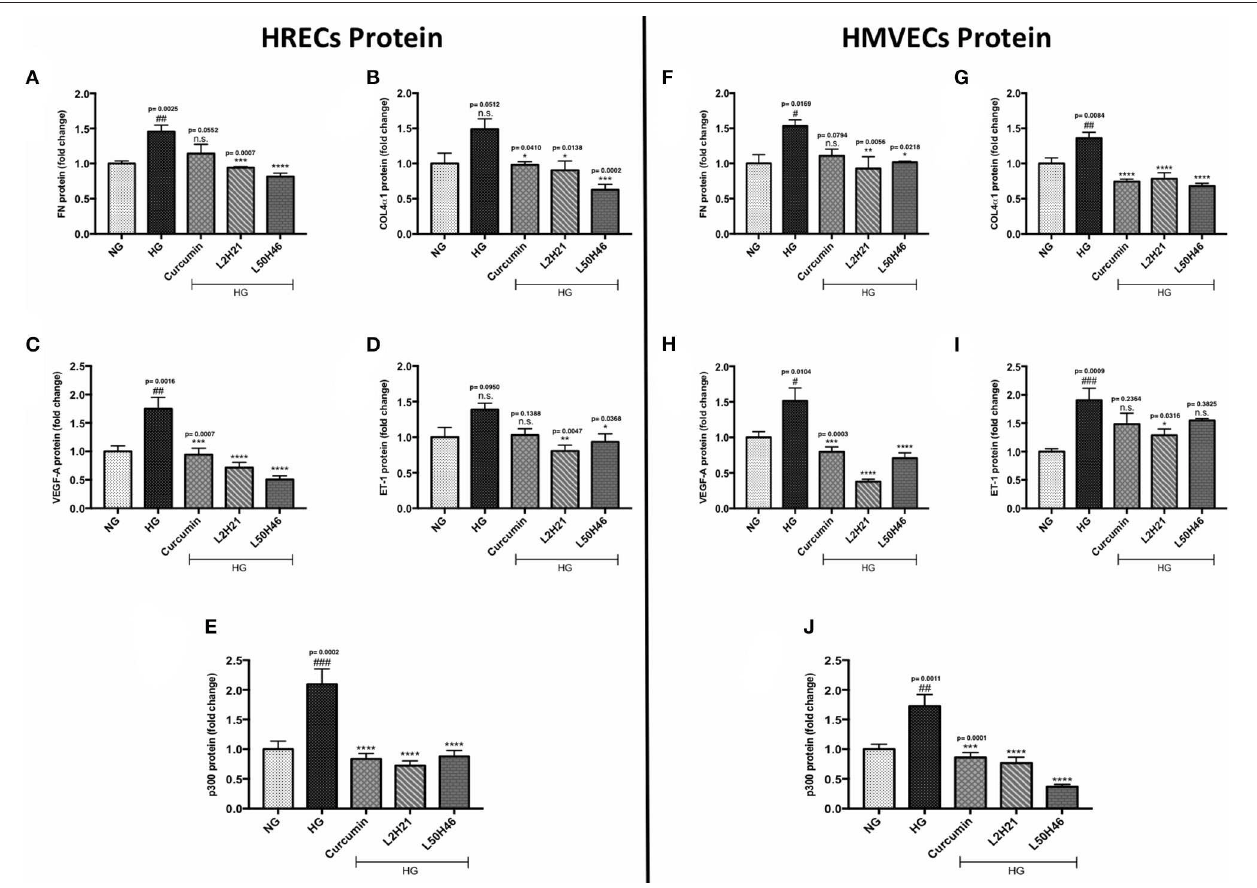
FIGURE 2 | Curcumin and its analogs alter proteins associated with glucose-induced vascular damage in vitro . Left panel: Protein levels of (A) FN, (B) COL4 α 1, (C) VEGF-A, (D) ET-1, and (E) p300 in HRECs pre-treated with L2H21 or L50H46 before exposure to HG. Protein levels were measured by ELISA. HG increased the selected proteins in HRECs, while the curcumin derivatives significantly reduced these glucose-induced upregulations. Right panel: Protein levels of (F) FN, (G) COL4 α 1, (H) VEGF-A, (I) ET-1, and (J) p300 in cultured HMVECs as described for HRECs. Following the treatment of curcumin or its analogs in HMVECs incubated with HG, the protein markers exhibited downregulation [data expressed as a fold-change (mean ± SEM); normalized to NG; # significance between NG vs. HG; *significance between HG vs. Treatment group; * , # P < 0.05, ** , ## P < 0.01, *** , ### P < 0.001, and **** , #### P < 0.0001; n = 6 from three independent experiments and performed in triplicates; n.s., not significant; NG (normal glucose) = 5mM D-glucose; HG (high glucose) = 25mM D-glucose; data analyzed by ANOVA followed by Tukey’s post-hoc ].